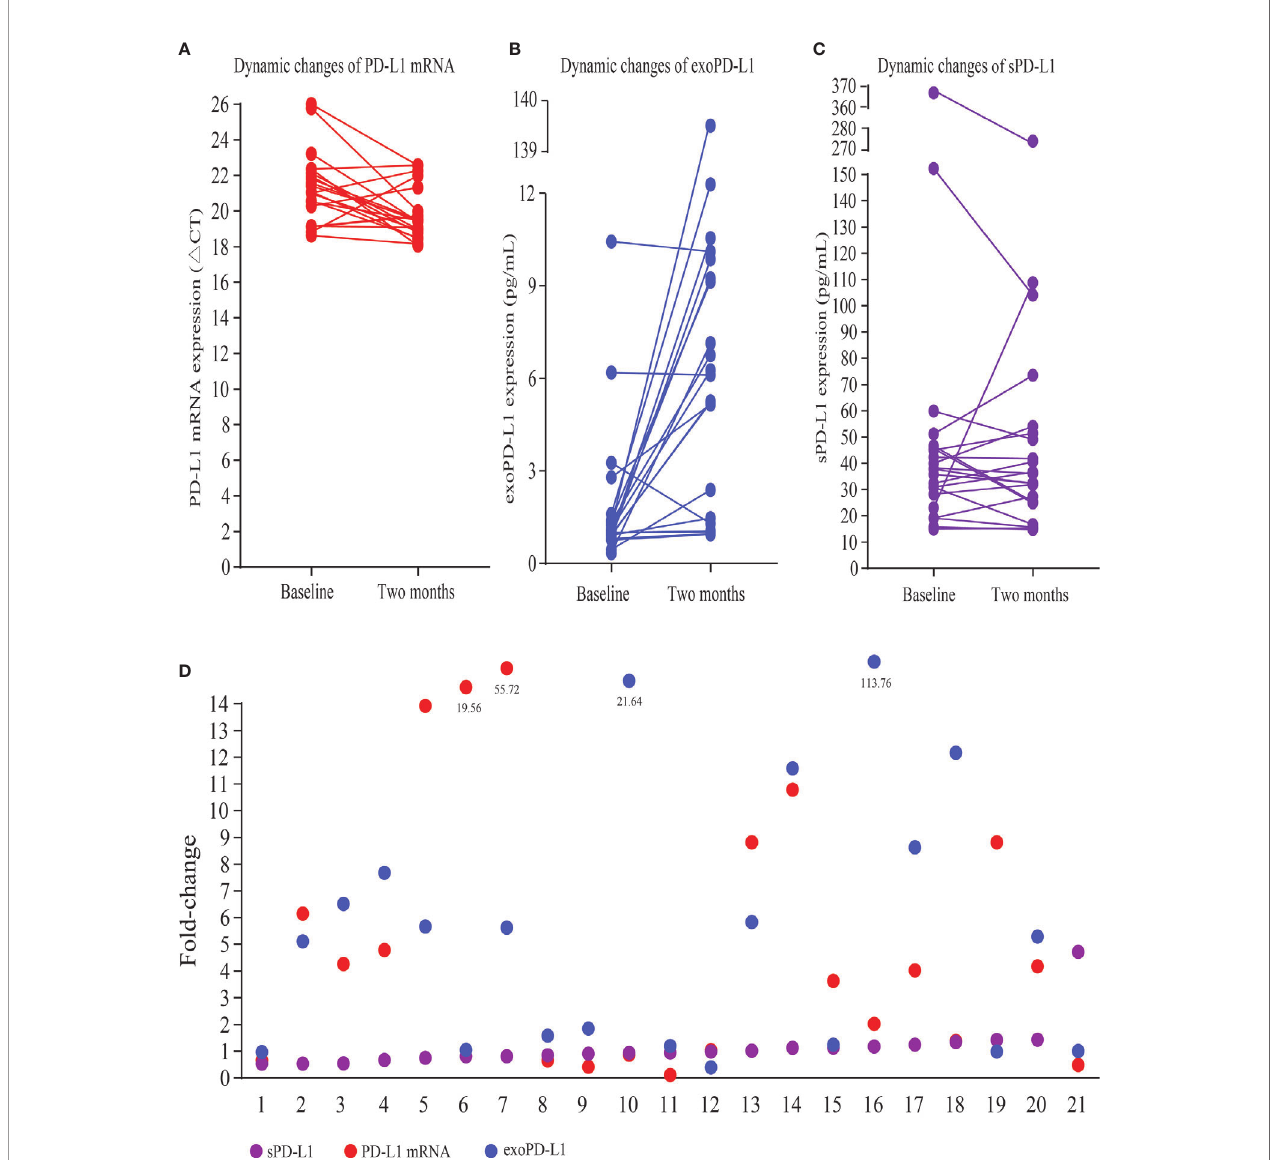
FIGURE 2 | Dynamic changes in multimodal bPD-L1 expression during early treatment. (A) Dynamic changes in PD-L1 mRNA (CT values). (B) Dynamic changes in exoPD-L1. (C) Dynamic changes in sPD-L1. (D) An overview of fold changes of the three biomarkers. bPD-L1, blood PD-L1; CT, cycle threshold; exo-PD-L1, exosomal PD-L1; sPD-L1 soluble